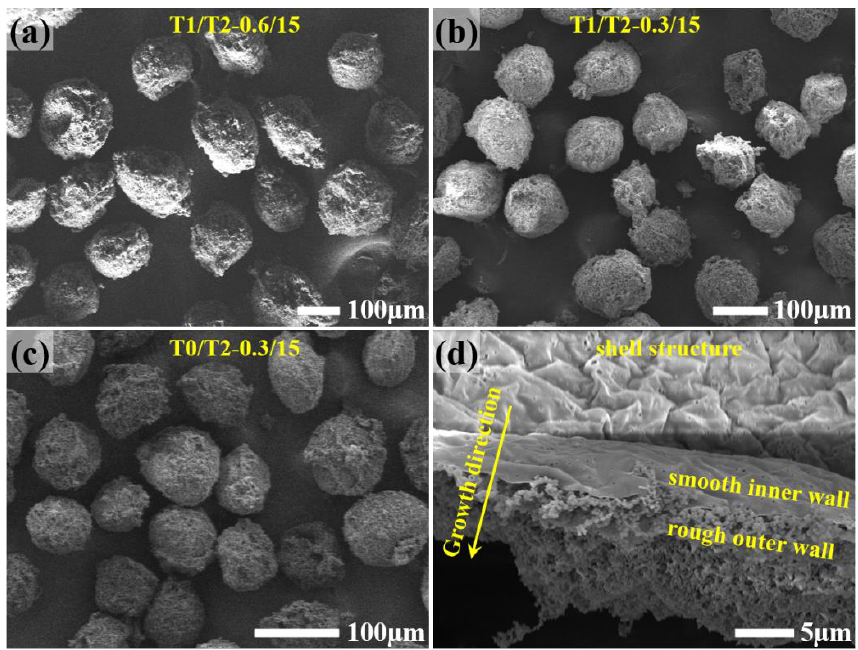
Figure 2. SEM images of the synthesized polyamine microcapsules using different T-junction units and different feeding rates for the polyamine. ( a ) Microcapsules synthesized using T1/T2 with a feeding rate of 0.6 mL/h for the polyamine; ( b ) microcapsules synthesized using T1/T2 with a feeding rate of 0.3 mL/h for the polyamine; ( c ) microcapsules synthesized using T0/T2 with a feeding rate of 0.3 mL/h for the polyamine; and ( d ) cross-section of the microcapsules synthesized using T1/T2 with a feeding rate of 0.3 mL/h for the polyamine.